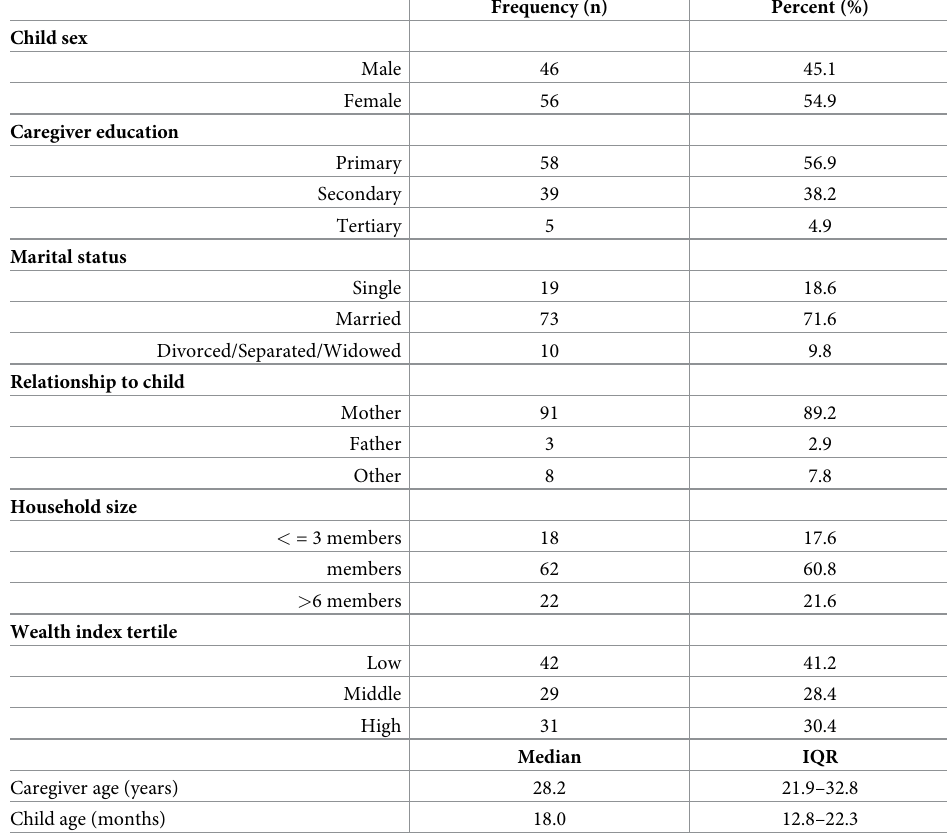
Table 2. Socio-demographic characteristics of primary caregivers and children, N =